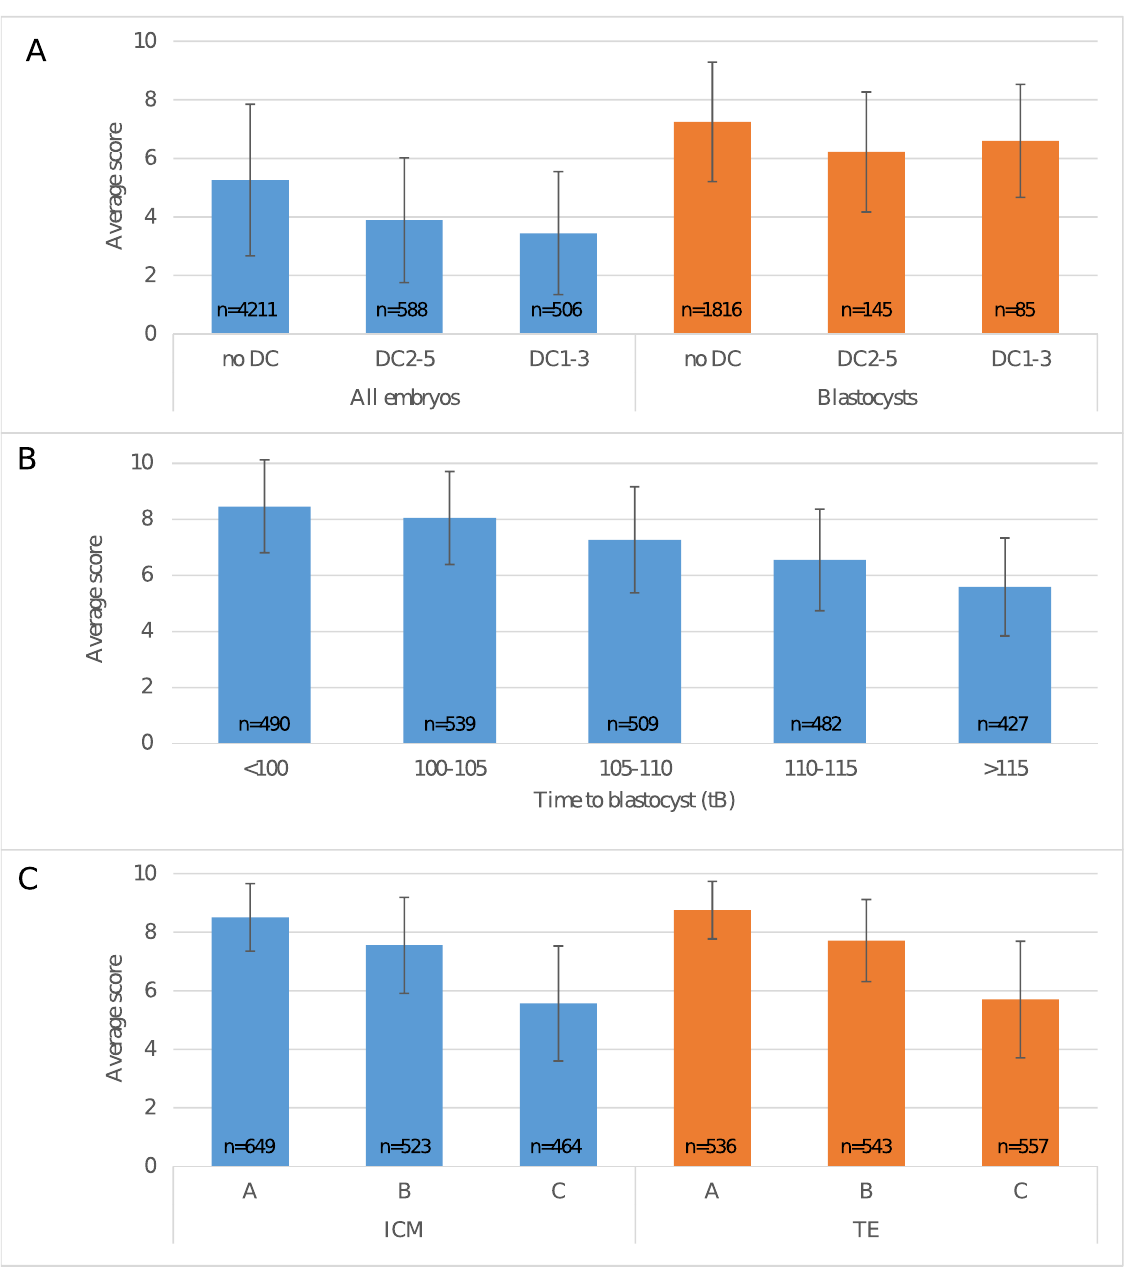
Fig 2. iDAScore for different morphokinetic groups. (A) Average score for embryos with no direct cleavages (no DC), direct cleavage from 2 to 5 blastomeres (DC2-5) or direct cleavage from 1 to 3 blastomeres (DC1-3), respectively. Average scores are shown for the whole cohort (n = 5305) and for embryos that reached the blastocyst stage (n = 2046). (B) Average score for blastocysts (n = 2447) where time to blastocyst was < 100, 100–105, 105–110, 110–115 or > 115 hpi, respectively. (C) Average score for embryos (n = 1636) with ICM and TE grades A, B or C, respectively. The number of embryos in each group is shown inside the bar. Lines show the standard deviation within each group.